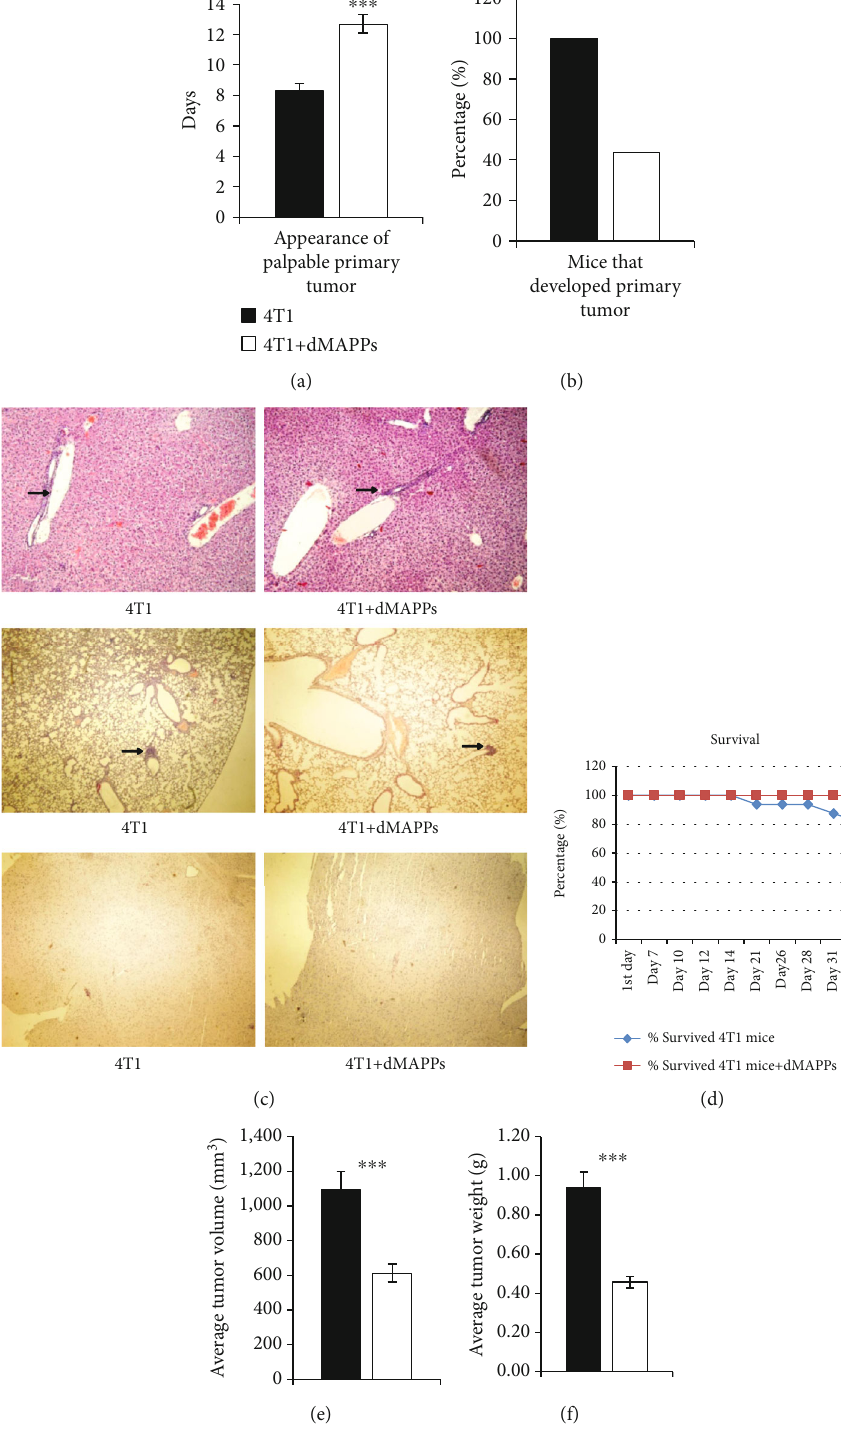
Figure 1: d-MAPPS delayed mammary tumor appearance and inhibited tumor growth. (a) Mean value of time period in days from inoculation of 4T1 breast cancer cells to the appearance of palpable primary tumor in 4T1+saline-treated (black bars) and 4T1+d- MAPPS-treated BALB/c mice (white bars). (b) Percentage of 4T1+saline- and 4T1+d-MAPPS-treated BALB/c mice after 36 days of follow-up. (c) Light-microscopic pictures (magni fi cation, × 10) through liver (upper panels), lung (middle panels), and brain tissue sections (lower panels) showing metastatic colonies (black arrows). (d) Survival of 4T1+saline-treated (blue line) and 4T1+d-MAPPS- treated mice (red line). The mean value of primary tumor (e) volume and (f) weight at day 36. Data are presented as mean + / − SEM ( n = 16 mice/group; ∗∗∗ p < 0 : 001